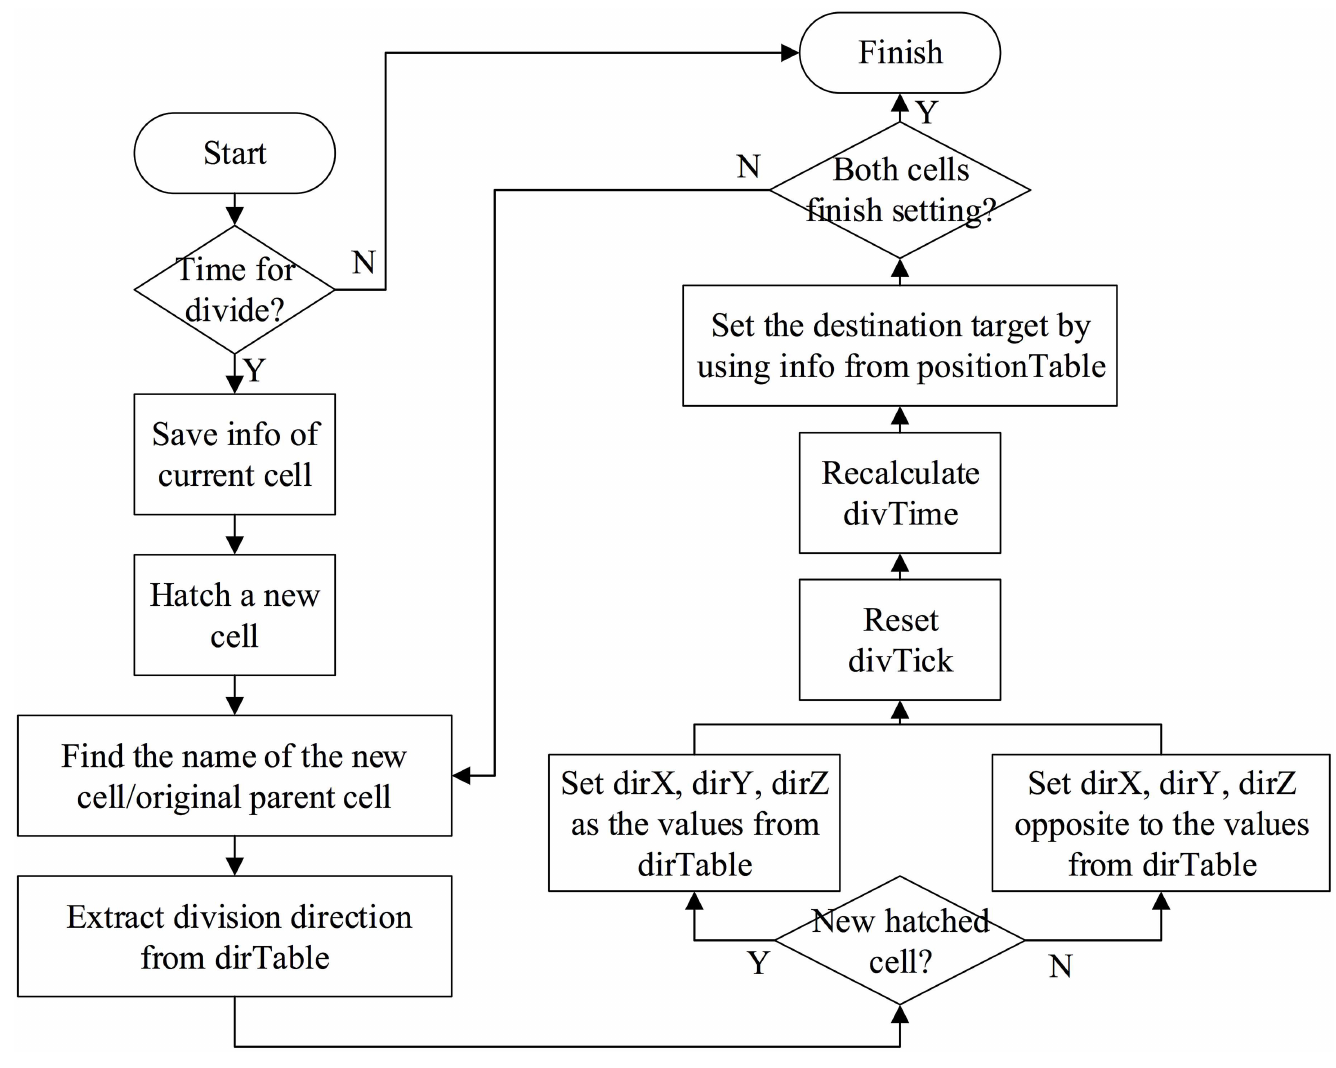
Fig 3. Divide activity of the